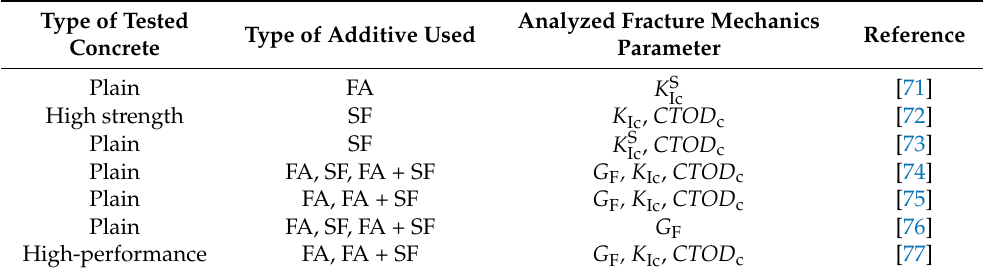
Table 1. Papers that presented the results of fracture toughness testing, during Mode-I loading, of concretes containing FA, SF, or FA + SF. Analyzed Fracture Mechanics Type of Tested Reference Type of Additive Used Parameter Concrete Plain FA K S [71] Ic High strength SF K Ic , CTOD c [72] Plain SF K S , CTOD c [73] Ic Plain FA, SF, FA + SF Plain High-performance